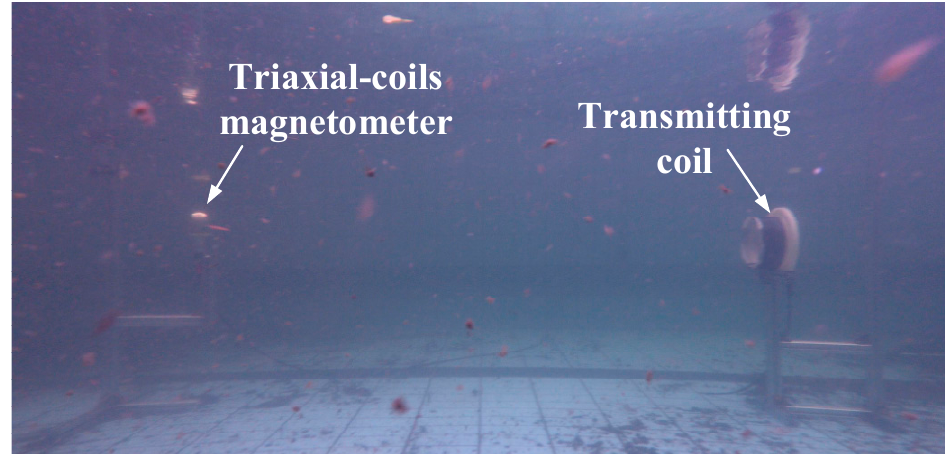
Figure 13. Underwater scene of electromagnetic positioning module. Table 6. System parameters calculated for each axis at different